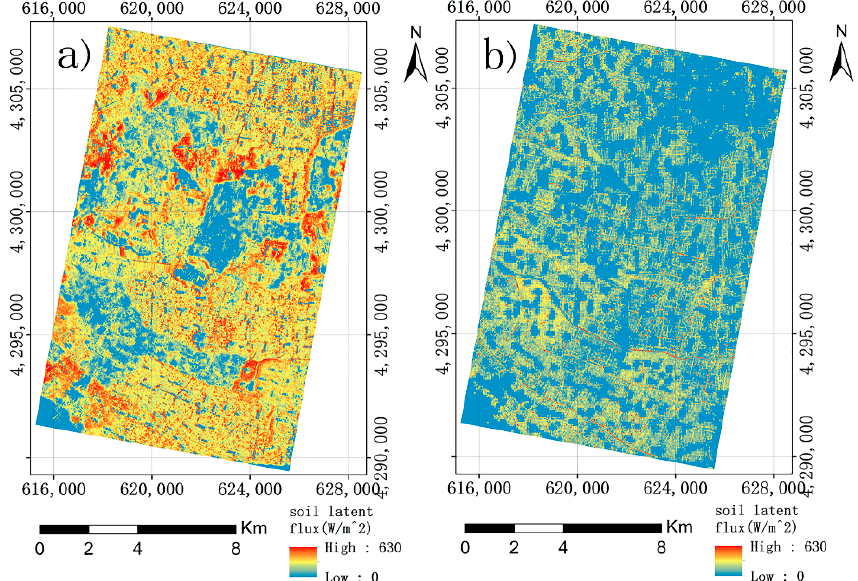
Figure 10. Spatial distribution of the soil latent flux using: ( a ) the June 4 th image and ( b ) the July 10 th image 2008, respectively.